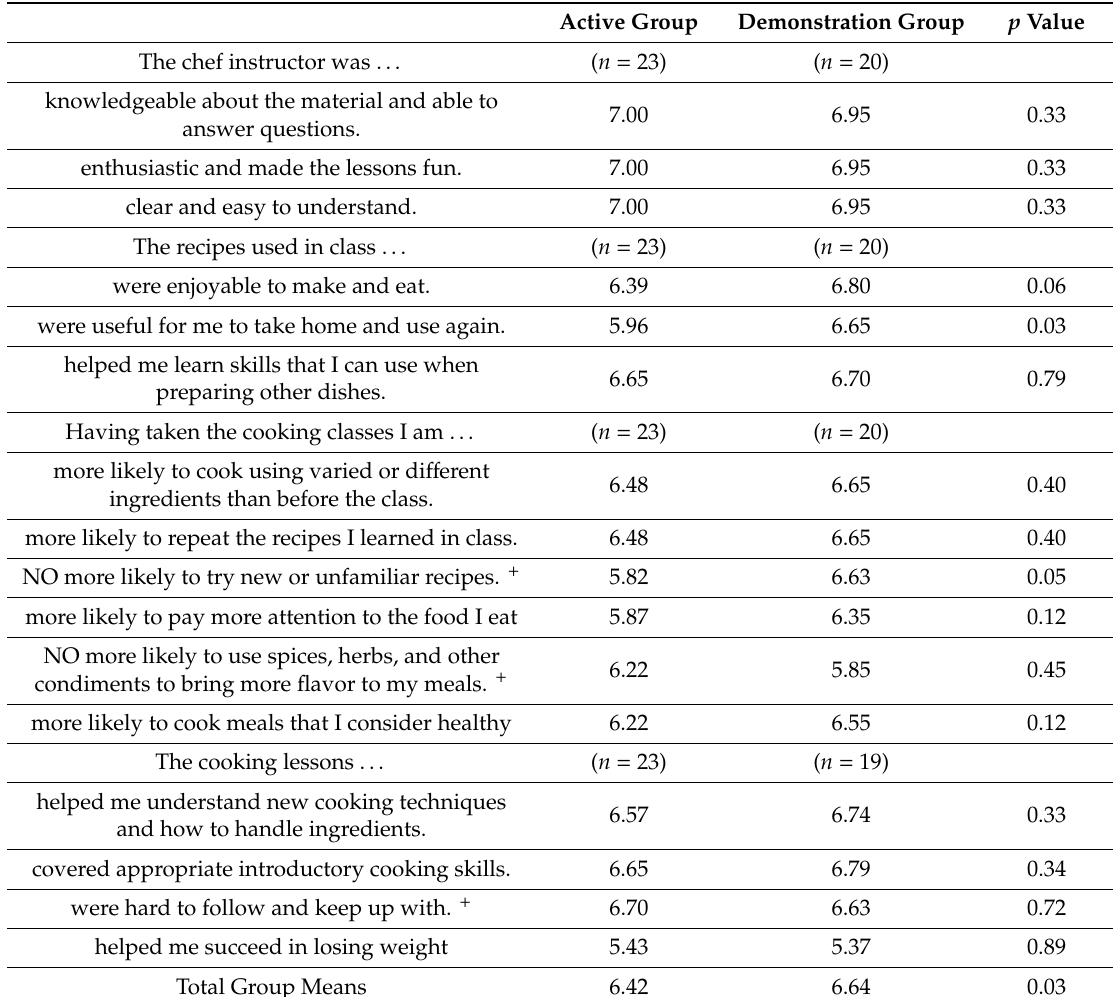
Table 5. Cont. Active